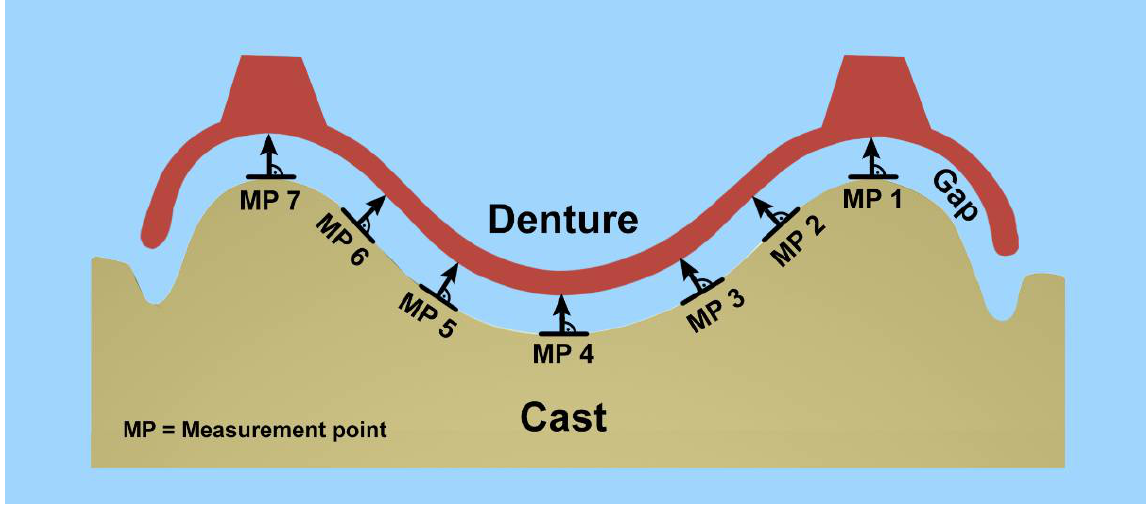
Figure 1. Schematic representation of the measurement points at the posterior border.